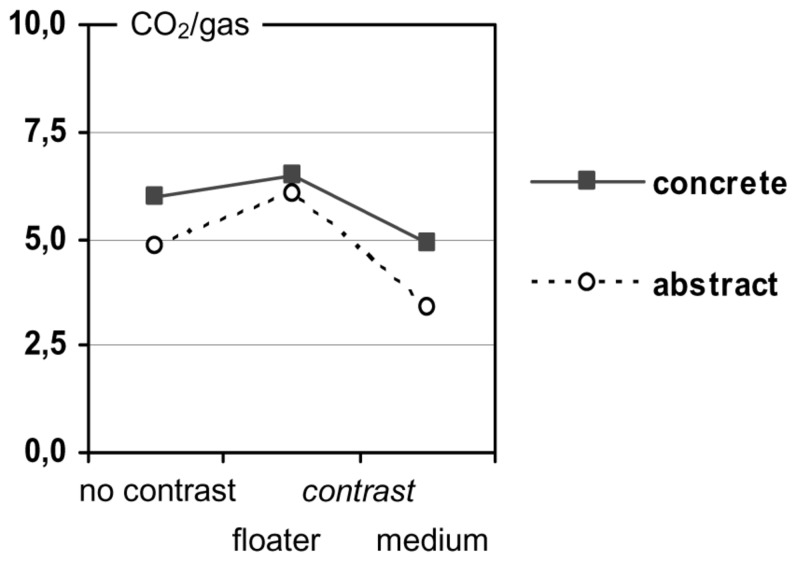
Preference for “CO2”/“the gas” as the prime cause in Experiment 2.